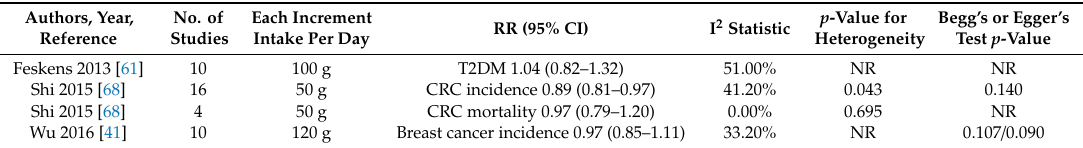
Table 16. Summary of linear dose-response meta-analyses of prospective studies on poultry intake and CVD, CHD, stroke, T2DM, CRC, breast